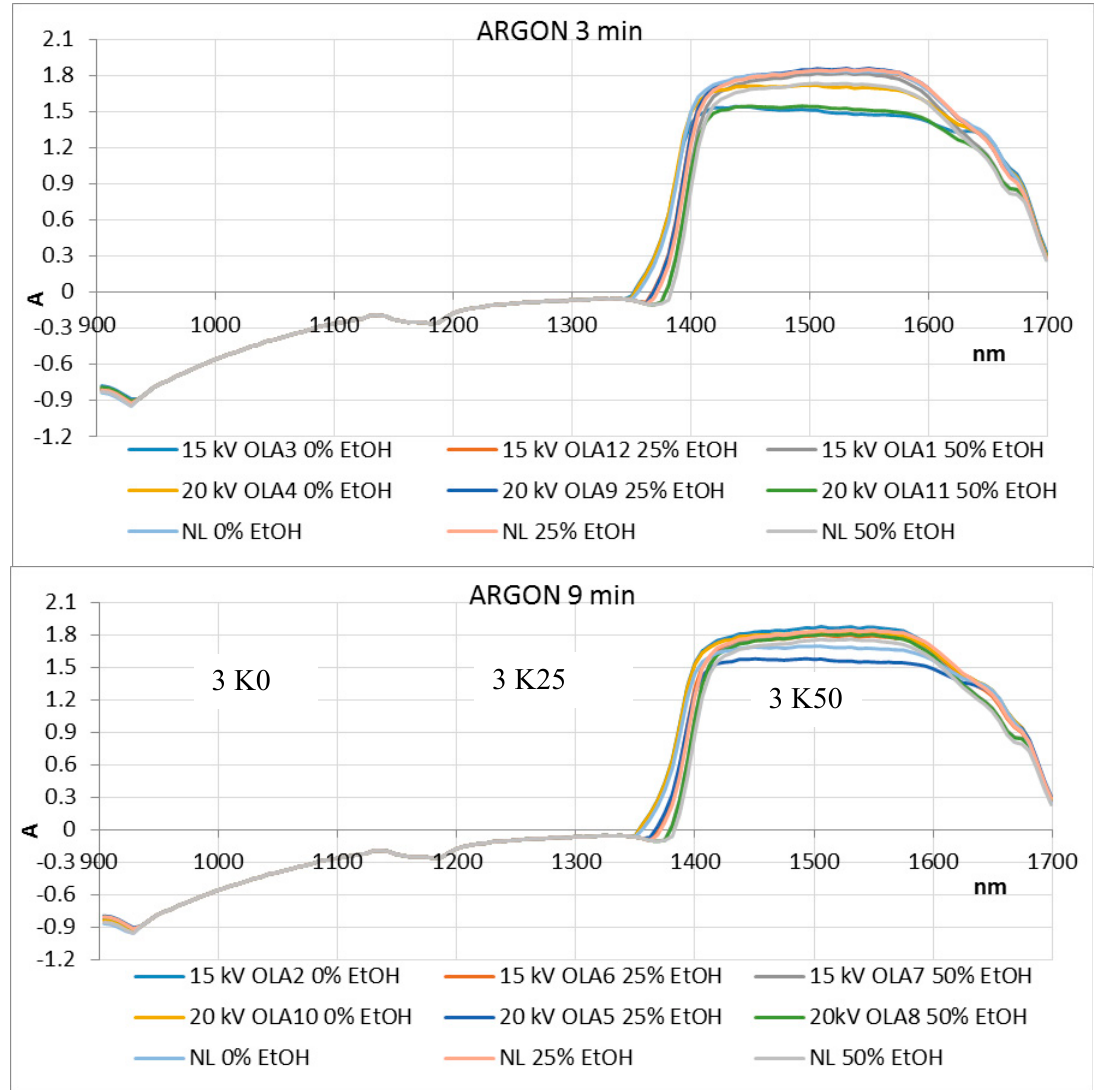
Figure 5. NIR spectra recorded in the wavelength range of 904 nm to 1699 nm for OLEs treated with argon for 3 and 9 min (NL: untreated olive leaves).